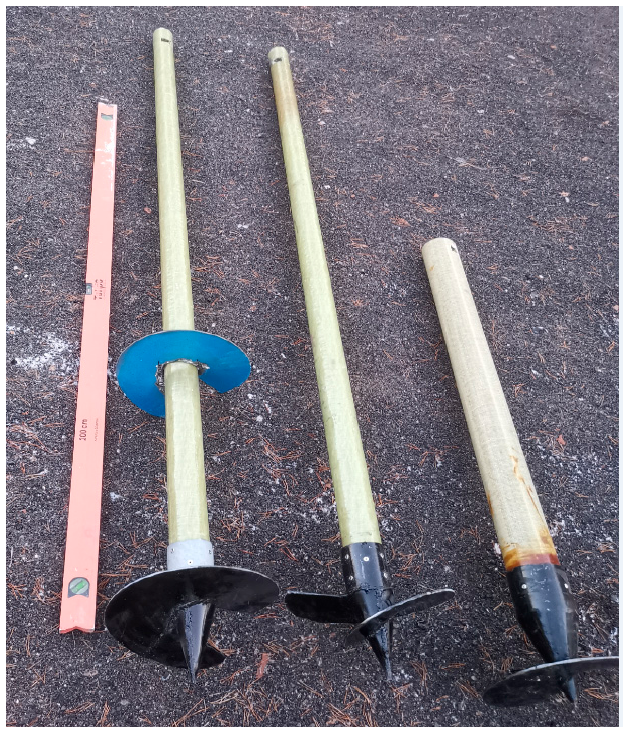
Figure 2. The investigated fiberglass reinforcing elements.